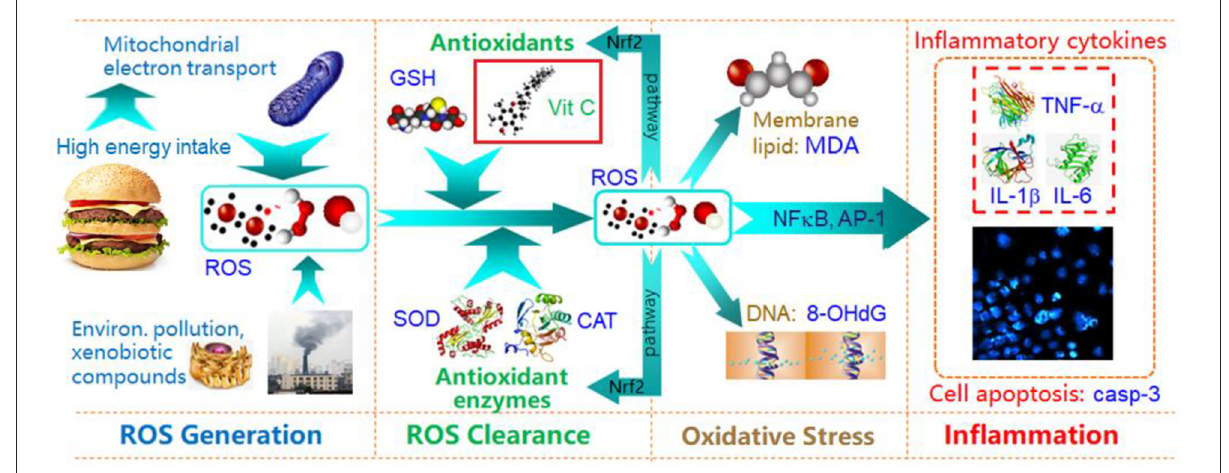
FIGURE4 Schematic diagram of energy intake, oxidative stress and inflammation, and Vit C protective effects.